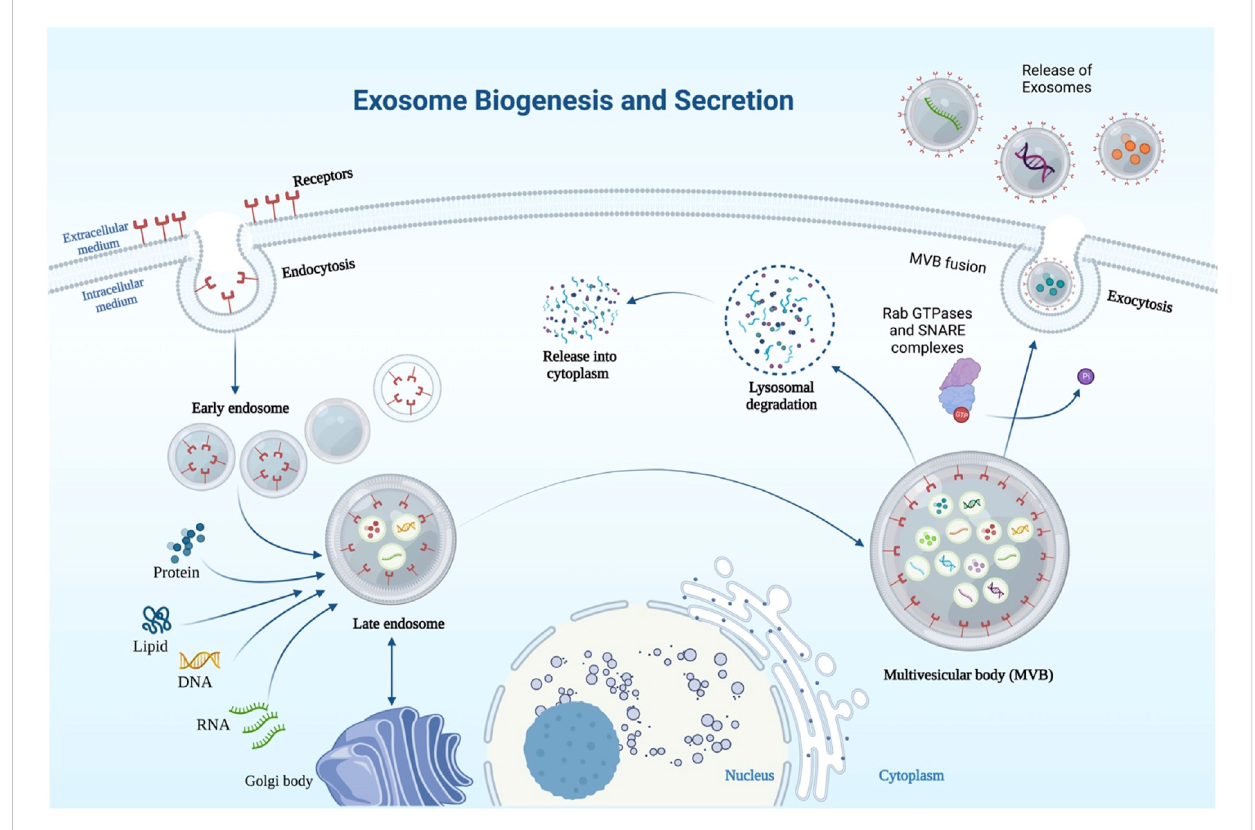
FIGURE 1 Schematic representation of exosome biosynthesis and secretion. Exosomes are formed through endocytic membrane invagination and ILV formation inside the cell. Payloads (RNA, proteins, DNA) are incorporated into ILV in an ESCRT-dependent or/and -independent manner during the maturation of early endosomes, which results in the formation of MVBs. MVBs with the plasma membrane results in the release of exosomes into the extracellular space, and MVBs can be transported along microtubules to the Golgi apparatus for endosome recycling or to lysosomes for degradation. Several key components including Rab GTPases and SNARE complexes are required for MVB fusion with the cellular